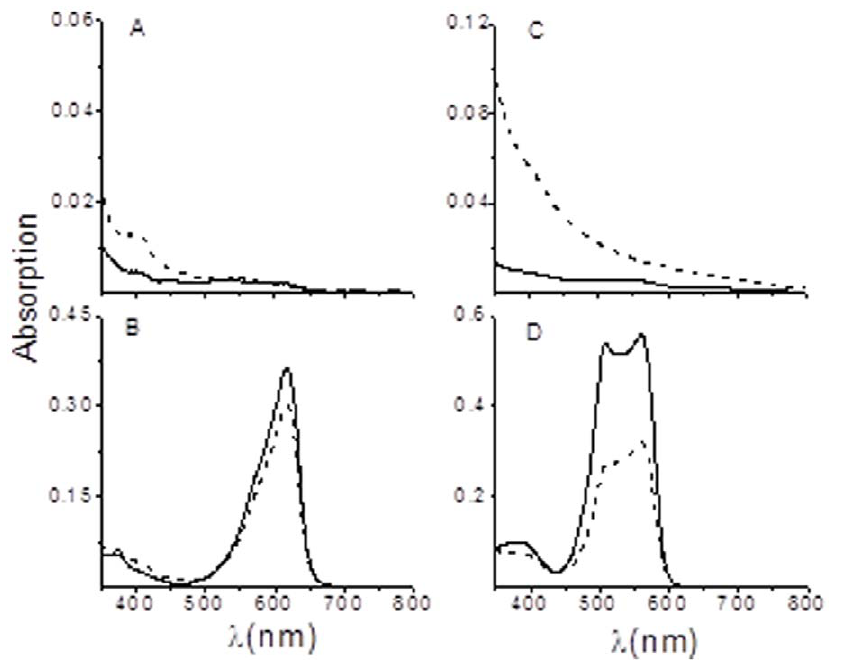
Figure 7. Assay of DOHH for phycocyanin a -84 lyase and phycoerythrocyanin a -84 lyase / isomerase activities. Absorption spectra of acceptor proteins, CpcA and PecA, after treatment with PCB in the presence (–) or absence (–) of DOHH, and purification by Ni 2 + affinity chromatography. (A) Assay for the attachment of PCB to CpcA. (B) In the additional presence of the lyase, CpcE /F. (C) Assay for PCB isomerizing to PVB and attachment to PecA. (D) In the additional presence of the isomerizing lyase, PecE /F. All reactions were carried out in E. coli (see Materials and methods for details).